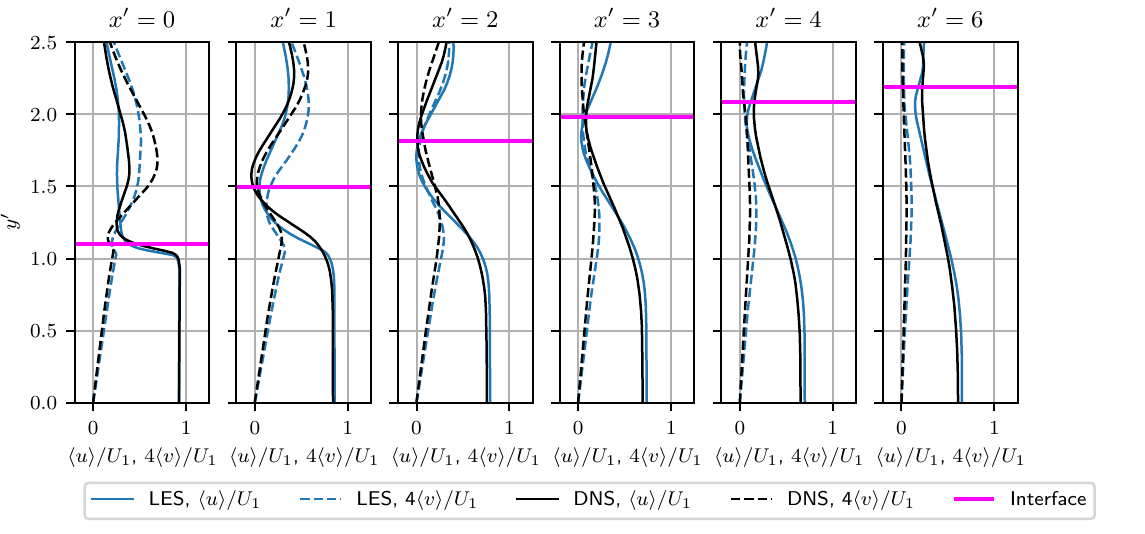
Figure 6. The profiles of (cid:104) u (cid:105) (solid lines) and 4 (cid:104) v (cid:105) (dashed lines) obtained in the benchmark simulation. The magenta line shows the location of the